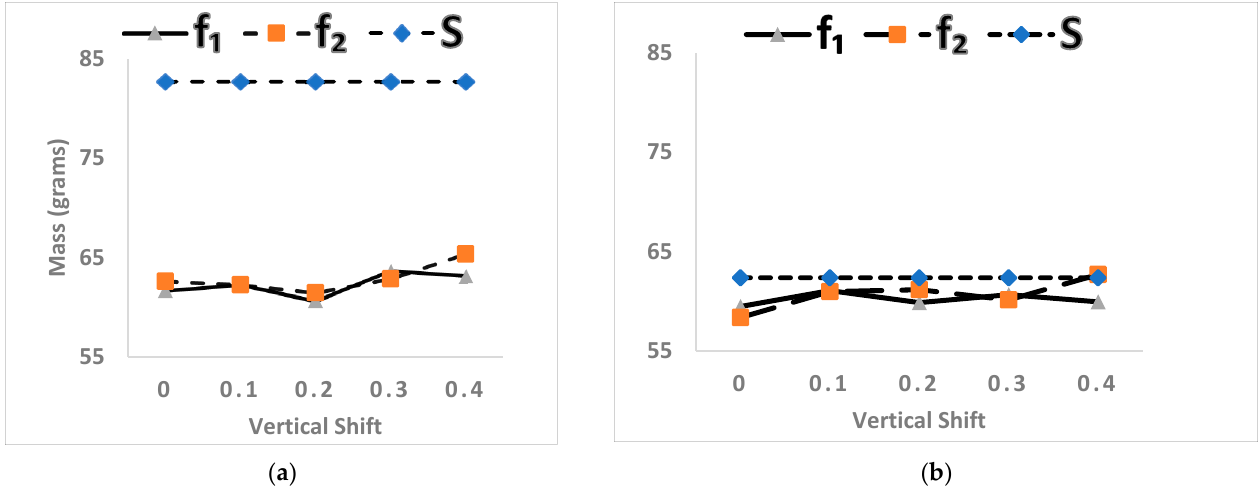
Figure 9. Graphical representation of the relationship between mass versus vertical shift ( a ) with 100% infill density ( b ) with 70% infill density.